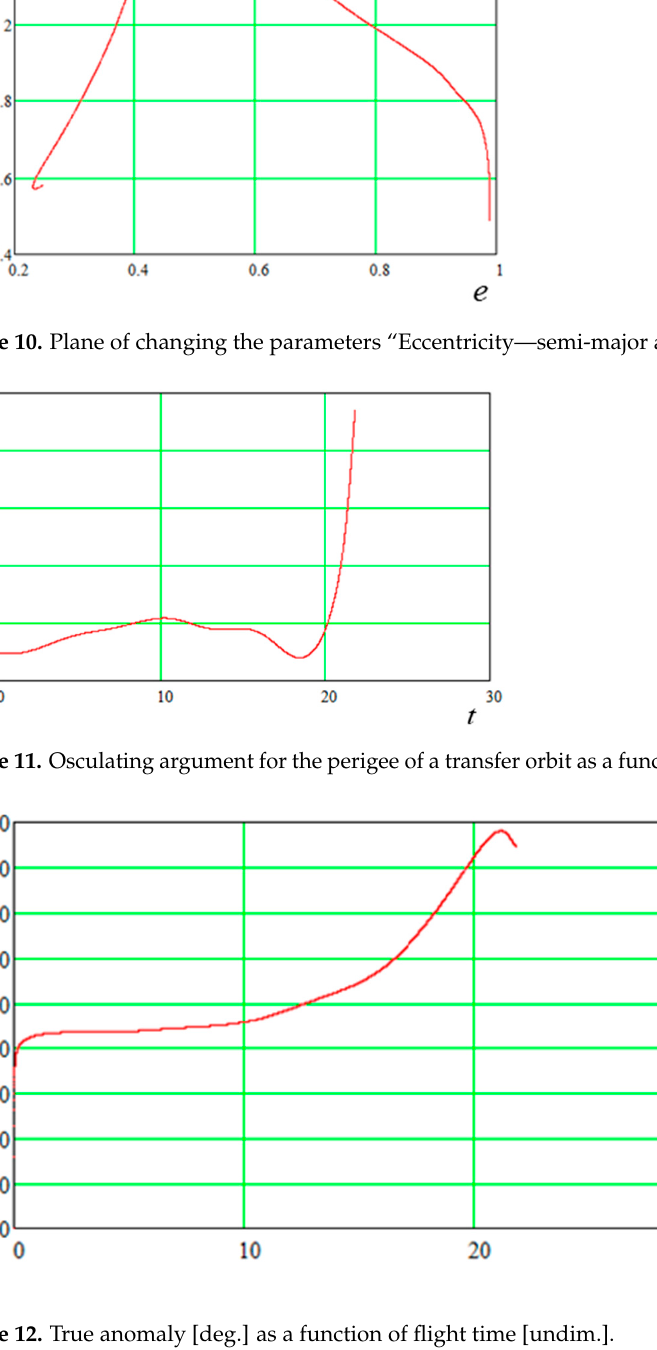
Figure 10. Plane of changing the parameters “Eccentricity—semi-major axis” [undim.].